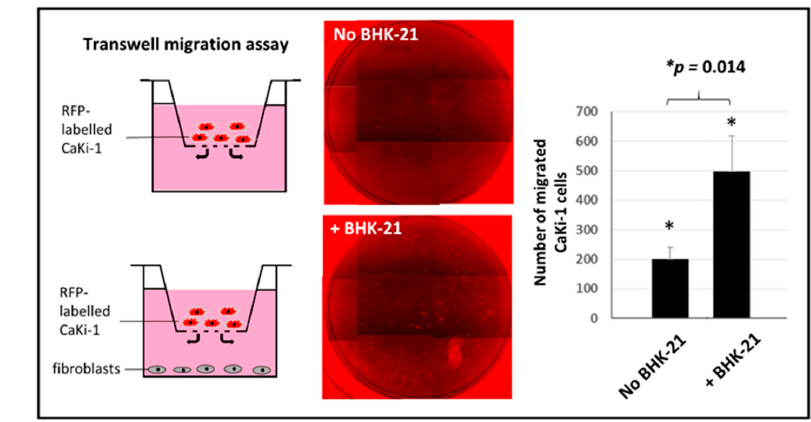
Figure 9. Chemoattraction of cancer cells by the fibroblasts as shown by a transwell migration assay. Addition of fibroblasts to the lower compartment of a Boyden chamber attracts significantly more CaKi-1 cells to traverse across the membrane ( p <